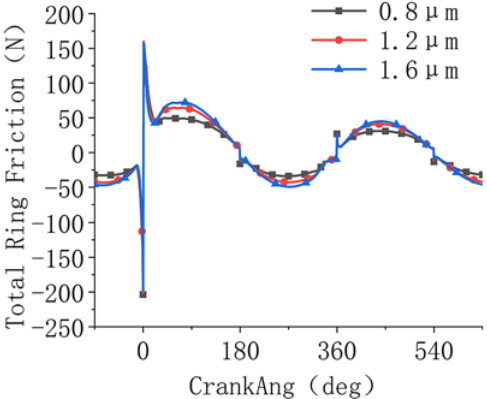
Fig. 20. Cylinder liner roughness friction relationship curve.